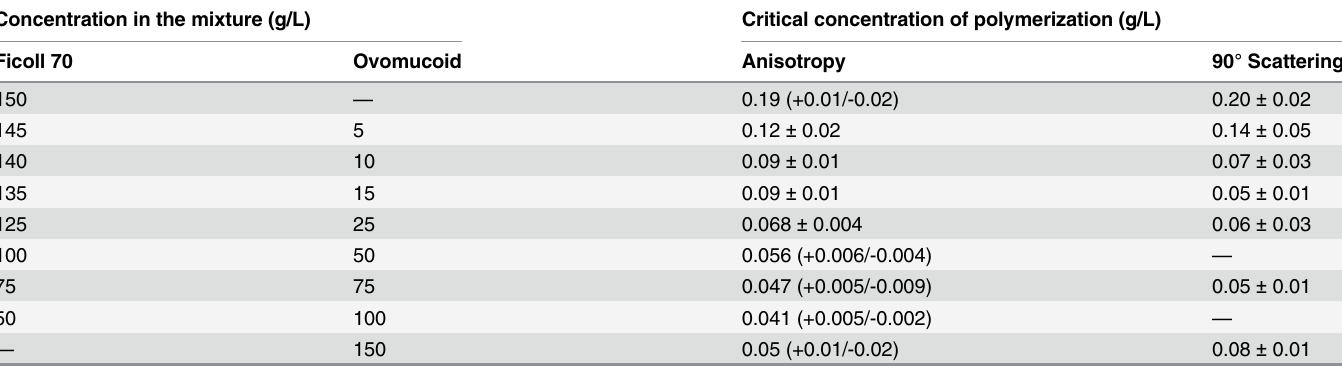
Table 2. Critical concentration of polymerization of FtsZ in the presence of mixtures of Ficoll 70 and ovomucoid in different proportions. Concentration in the mixture